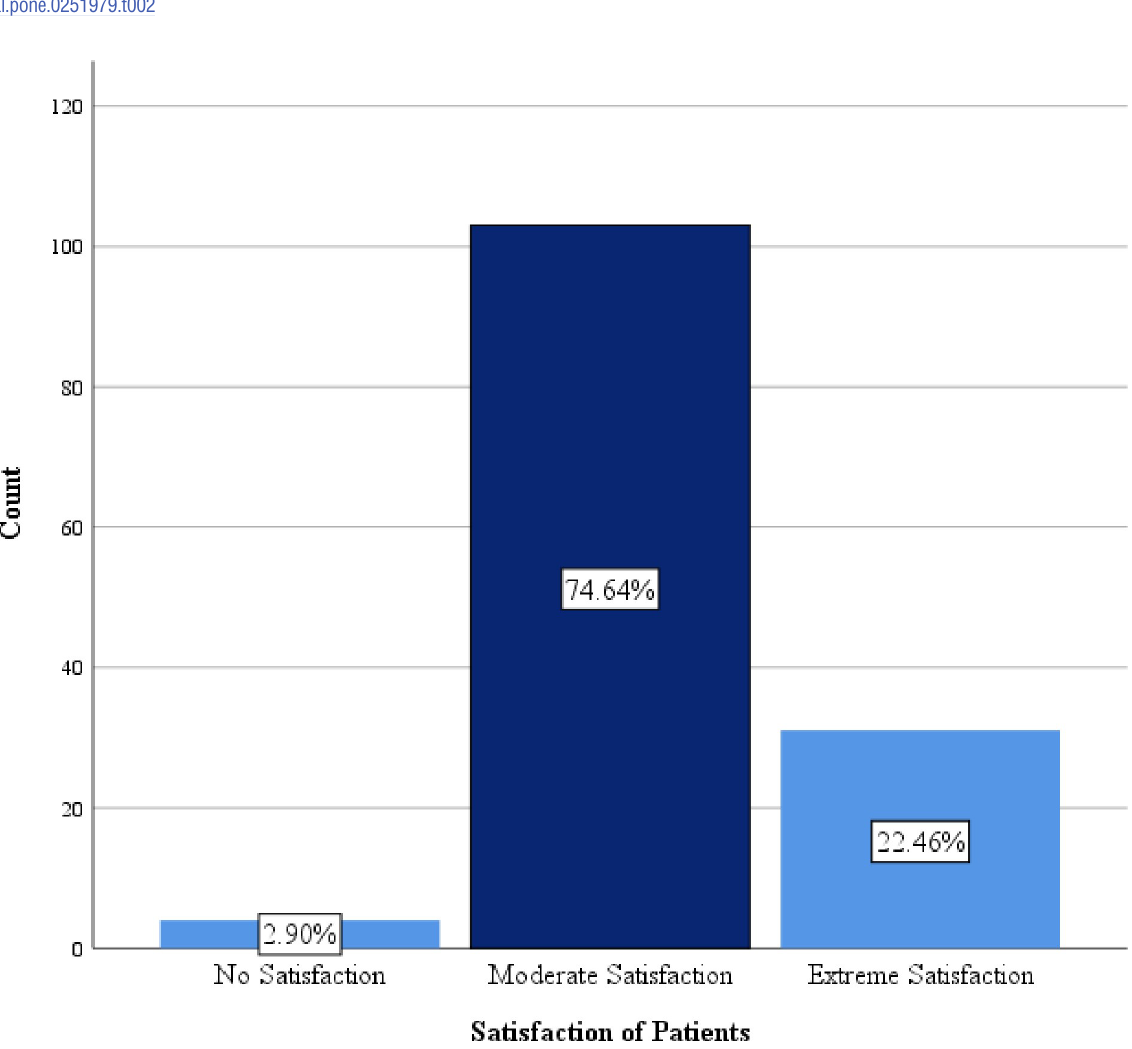
Fig 1. Patient satisfaction with pain treatment received since